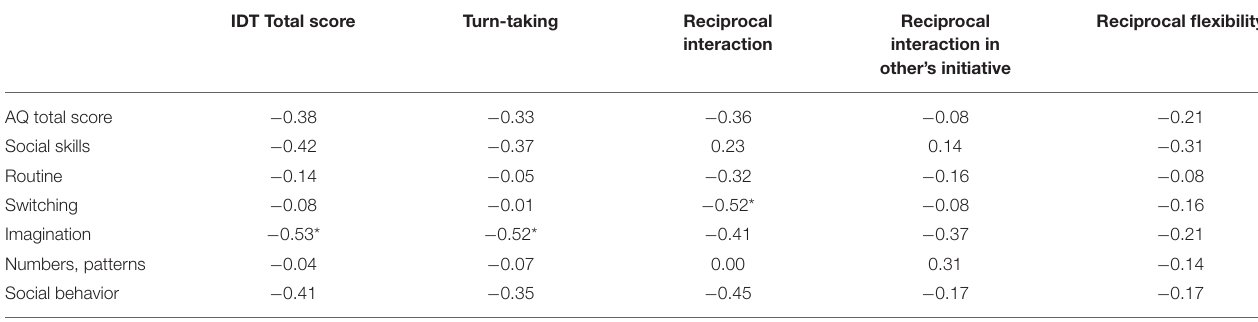
TABLE 4 | Correlations between IDT scale scores and AQ scale scores in the ASD group.